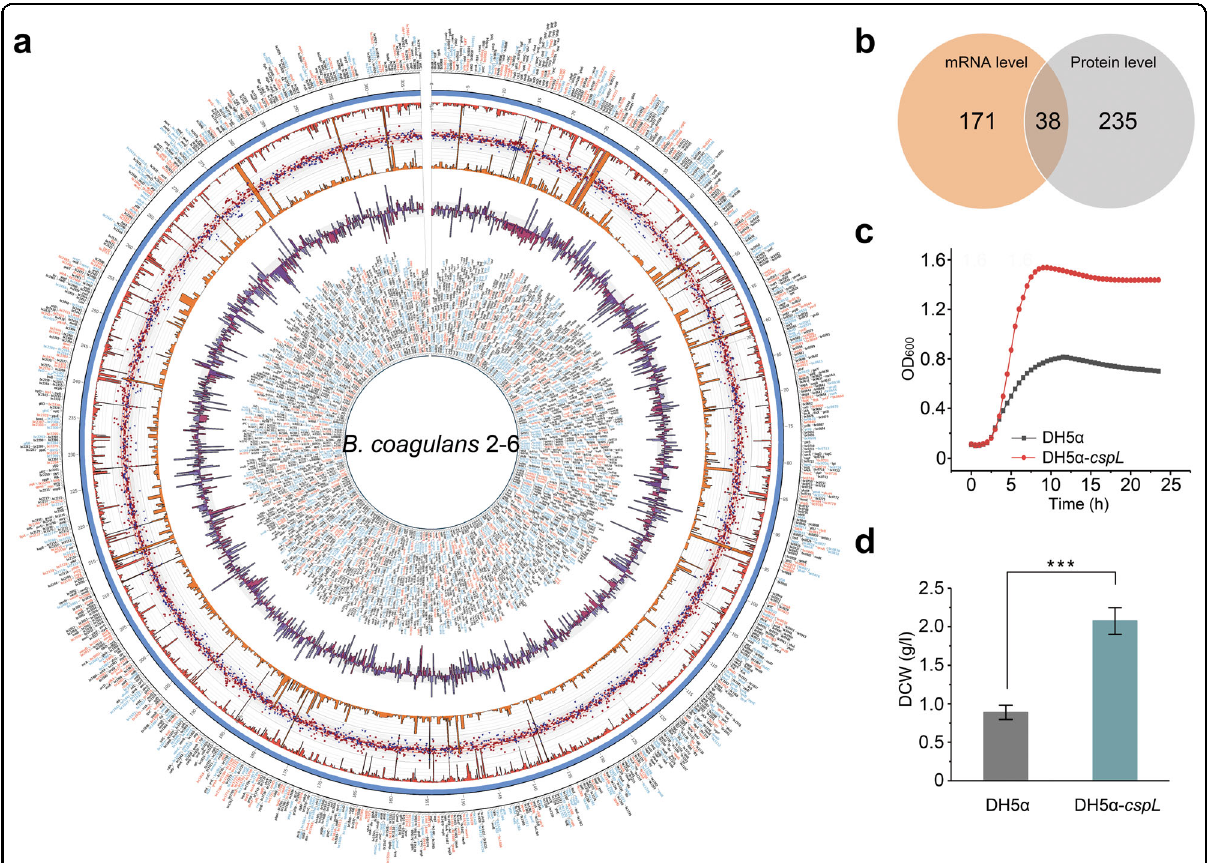
Fig. 1 Screening and identifying candidate genes associated with high temperature growth. a Global view of B. coagulans 2-6 transcriptome and proteome analysis at 37 °C and 60 °C. Concentric circles from the periphery to the core represent the following: (i) differential proteome analysis; the font color of the protein names indicates whether a protein is downregulated (blue), upregulated (red), or shows no signi fi cant change (gray) at 60 °C; (ii) chromosomal location; (iii) bar chart in red (inner orientation) representing gene expression levels at 60 °C; (iv) scatter diagram representing protein expression at different conditions (red squares and blue triangles represent 60 °C and 37 °C, respectively); (v) bar chart in orange (outer orientation) representing gene expression levels at the 37 °C condition; (vi) bar chart representing differential expression of the same gene at the mRNA (purple) and protein (blue) levels; (vii) transcriptome analysis; the font color of the gene names indicates whether a gene is downregulated (blue), upregulated (red), or shows no signi fi cant changes (gray) at 60 °C. b Venn diagram depicting the numbers of genes upregulated at the mRNA and protein levels in B. coagulans 2-6. c Functional analysis of DH5 α - cspL at 45 °C. Compared with the control group, DH5 α - cspL shows a